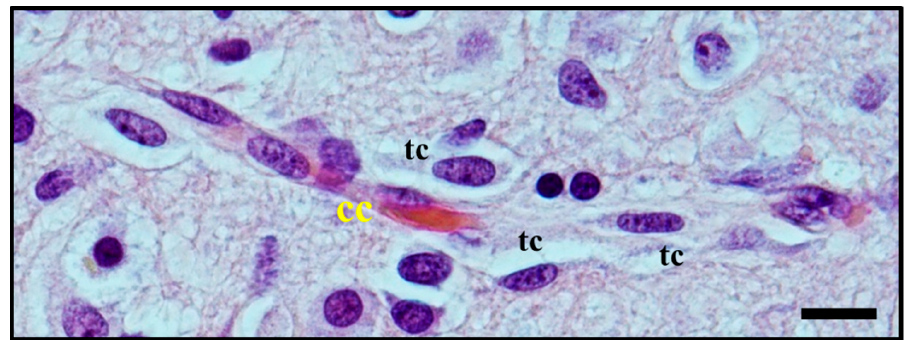
Figure 3. Histological observation of perivascular satellitosis . Atypical glial tumour cells (tc) moving and stretching along capillary vessels: increase in nuclear size of endothelial capillary cells (cc) is a sign of their metabolic reaction to tumour cells aggression and makes nuclei bulge into vessel lumen. Original image collected at 400 × magnification and relative regions of interest (ROI) are reported. The scale bar is 50 µm.